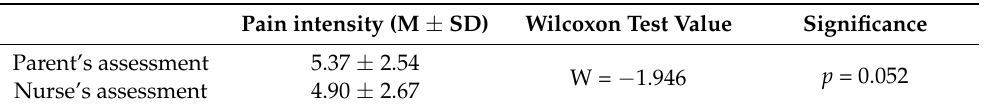
Table 6. Difference in the FLACC pain scores reported by the nurses and the parents. Patients were <4 years of age.